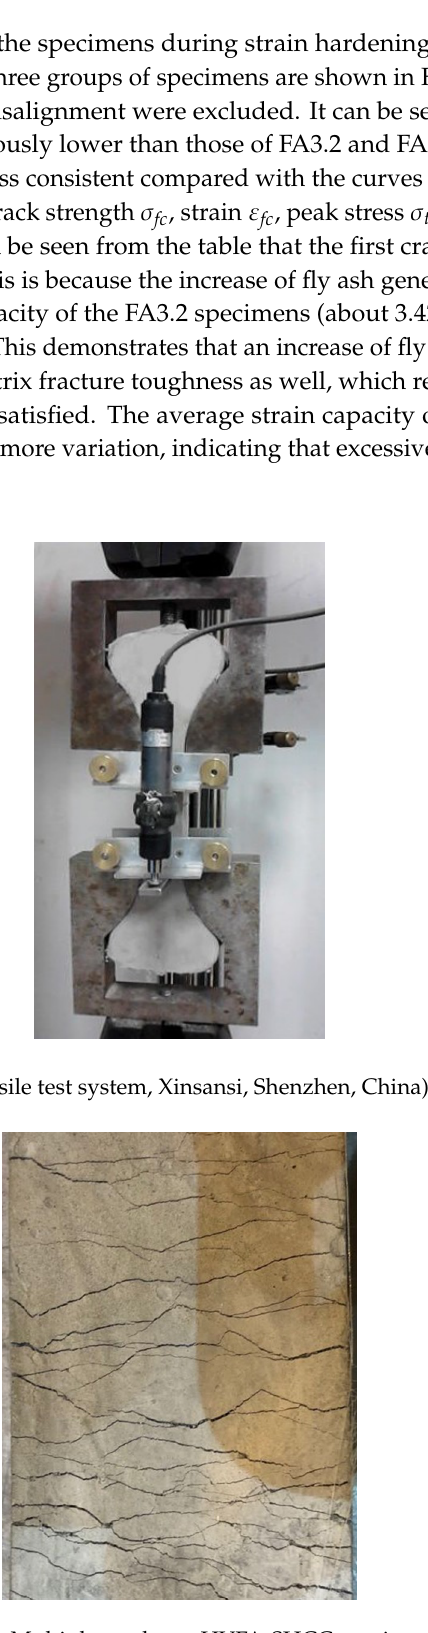
Figure 6. Multiple cracks on HVFA-SHCC specimens.